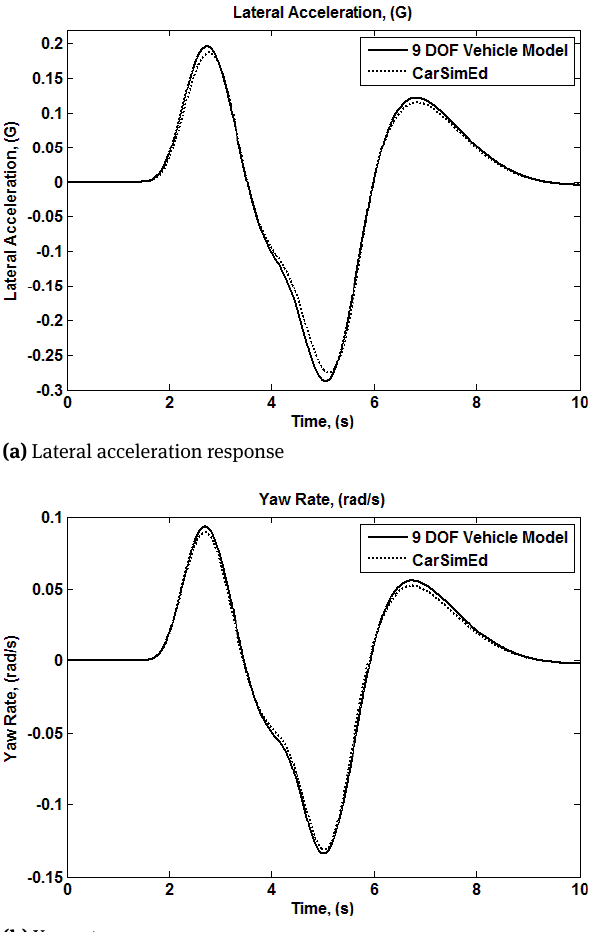
Figure 8: Double lane-change test at 80 km/h constant speed with no braking